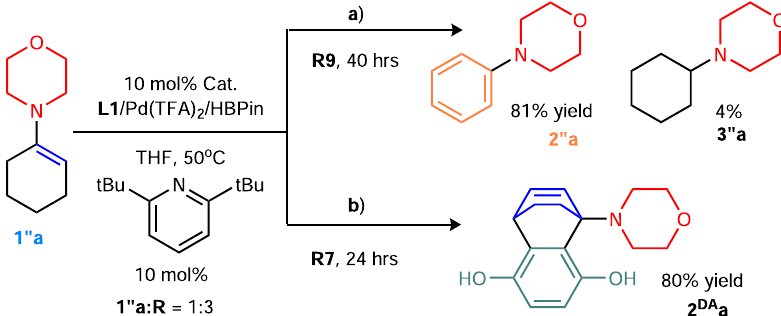
Fig. 6 | Catalytic synthesis ofa substituted aniline and dehydrogenative Diels-Alder product.a Synthesis of a substitutedaniline. b Trapping the diene for the Diels- Alder